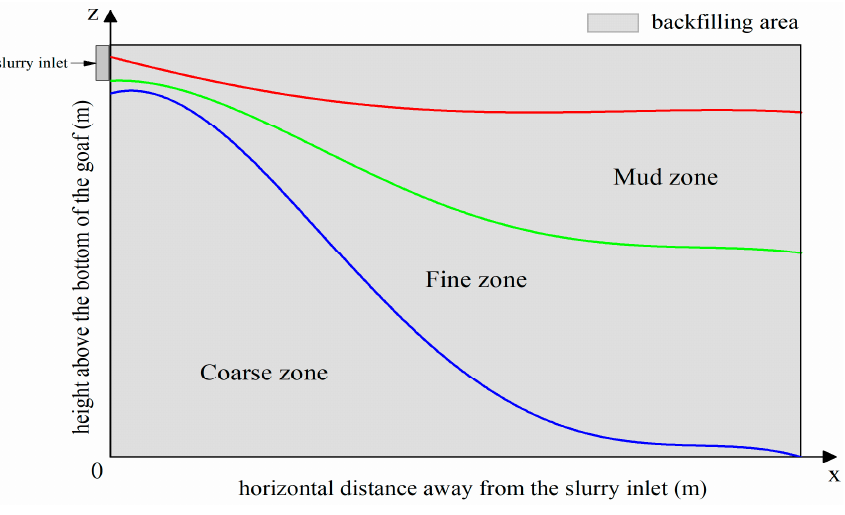
Figure 1. The three areas and dividing lines of CPB.